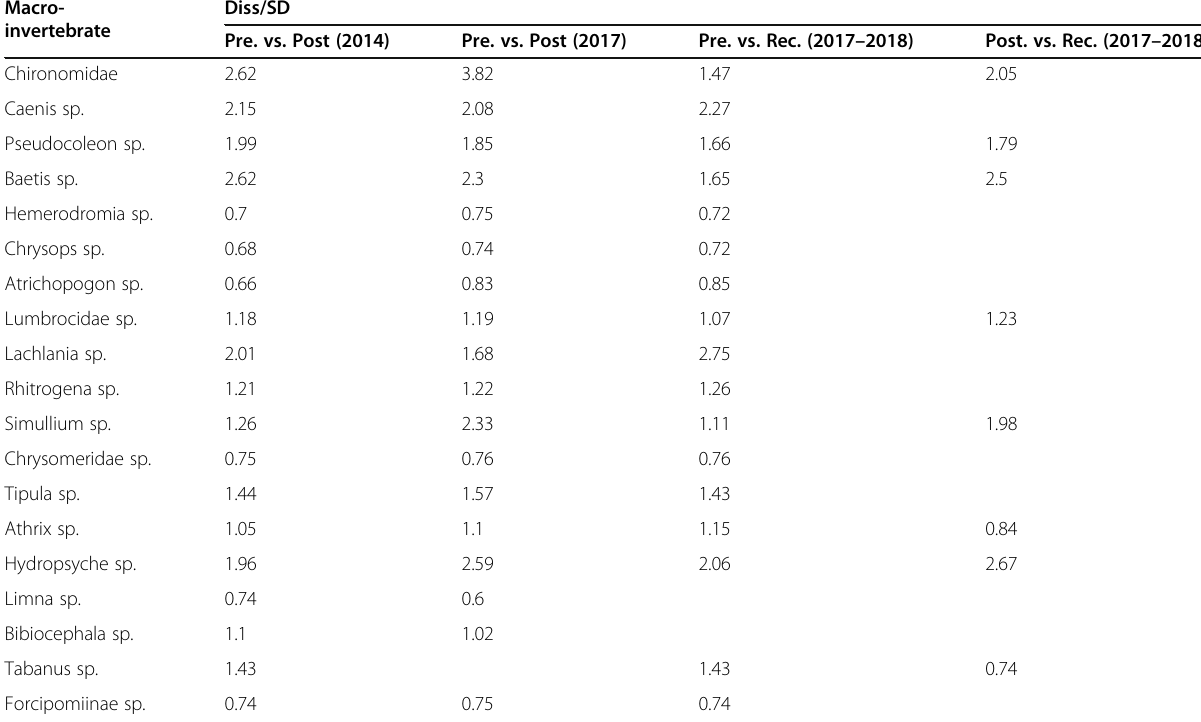
Table 1 List of macroinvertebrates which cumulatively account for >50% of the dissimilarity (Diss/SD) between sample event groups. Values represent their percent contribution to the dissimilarity between sample groups. Sample groups are categorized as pre-flood (Pre.), post-flood (Post.), and recovery